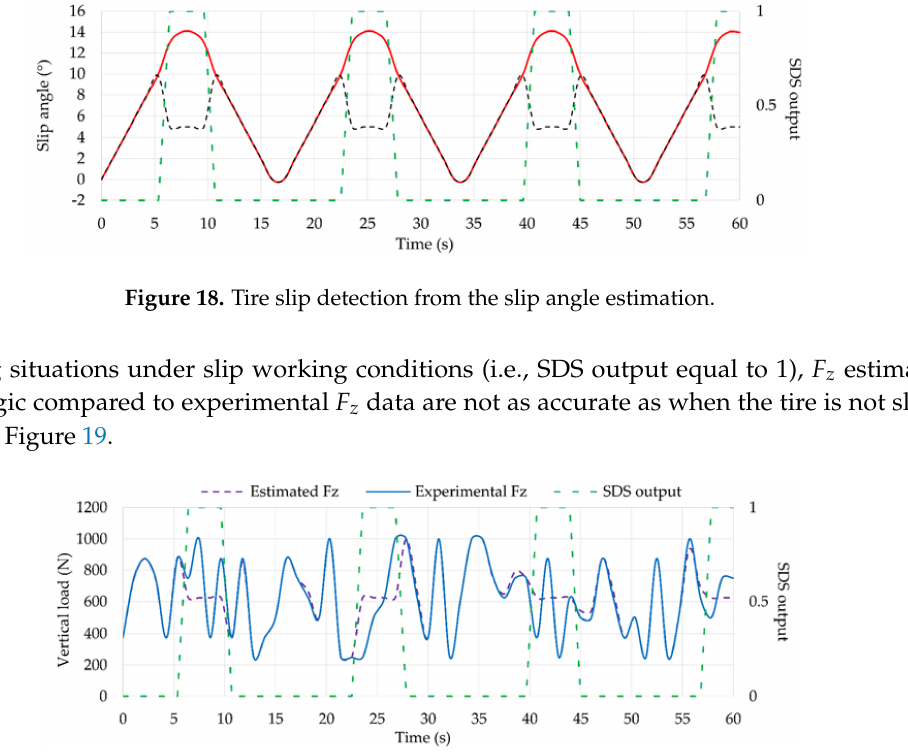
Figure 19. Simulation results of F z compared to experimental values.